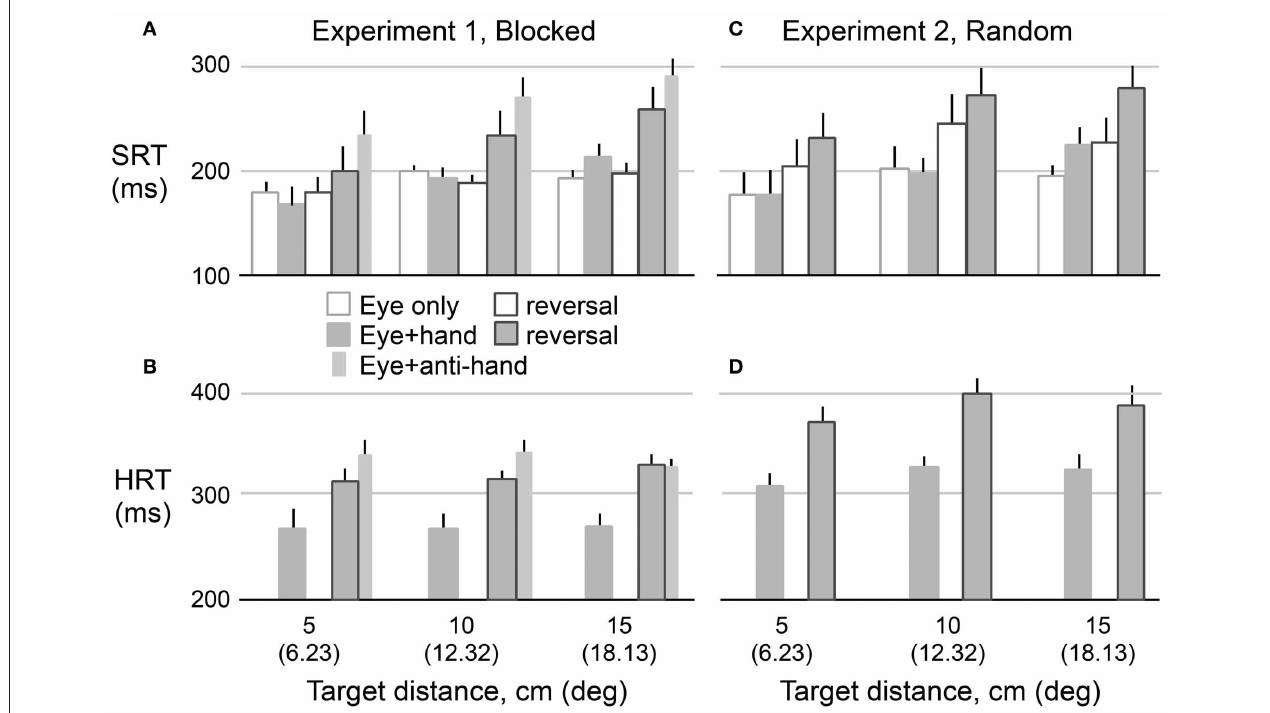
FIGURE 3 | Mean reaction time as a function of target amplitude for eye movements (SRT) in Experiment 1 (A) and Experiment 2 (C) and hand movements (HRT) for both experiments (B,D). Hollow bars represent eye